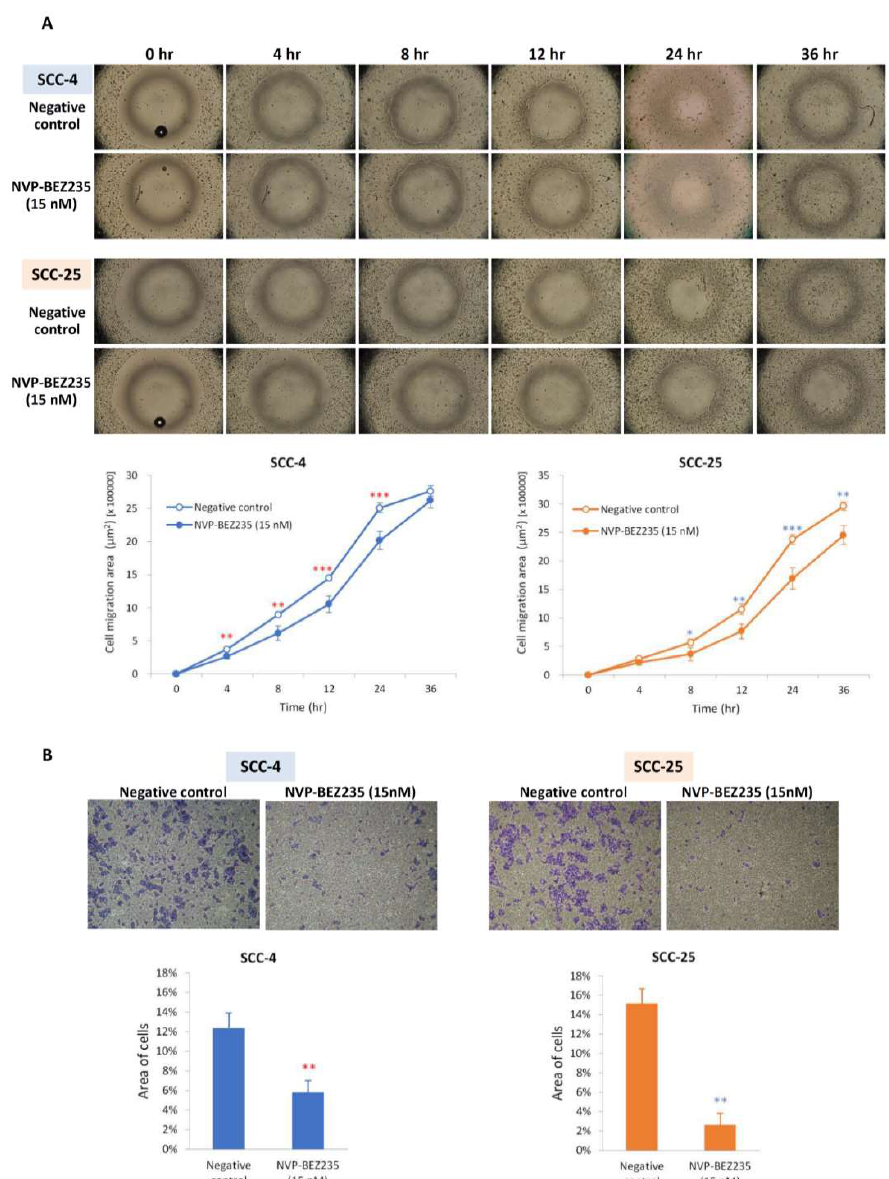
Figure 3. NVP-BEZ235 inhibited the migratory and invasion capabilities of SCC-4 and SCC-25 cells. ( A ) Wound-healing assay determined that SCC-4 and SCC-25 cells had shorter migration distances after NVP-BEZ235 treatment. * p < 0.05, ** p < 0.01, and *** p < 0.001 indicate the statistical significance of differences at one point in time between the results for cells with and without treatment. Hollow dots are for negative controls and solid dots are for NVP-BEZ235 treatments. ( B ) After incubating for 24 h (SCC-4) or 48 h (SCC-25) with transwell chambers, the area of migratory or invasive cells was markedly decreased in NVP-BEZ235-treated cells in comparison with cells without treatment. ** p < 0.01 indicates the statistical significance of the differences between cells with and without treatment (red ** for SCC-4 and blue ** for SCC-25).